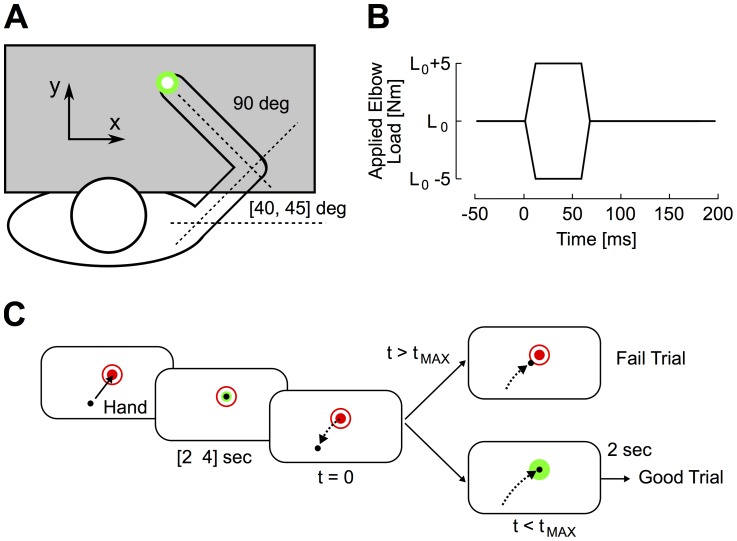
Experimental procedure.A: Overhead representation of a participant performing the task. The hand aligned cursor (white dot) and the visual targets were projected on the virtual reality display and direct vision of the arm was blocked. B: Perturbation pulses applied on the elbow joint (±5 Nm, 50 ms with linear ramp-up/down of 10 ms) were added to the background torque (L0 = +2, 0 or −2 Nm, see Methods). C: Illustration of the time course of a trial. Participants were instructed to reach for the centre of the start target (red dot). The perturbation was applied after a random time delay ranging from 2 sec to 4 sec. Participants had to return to the goal target (red circle) within the prescribed time constraint (tMAX = 300 ms or 600 ms), and stabilize in this target for 2 sec. A green or red goal target indicated success or failure to meet the timing criterion, respectively.